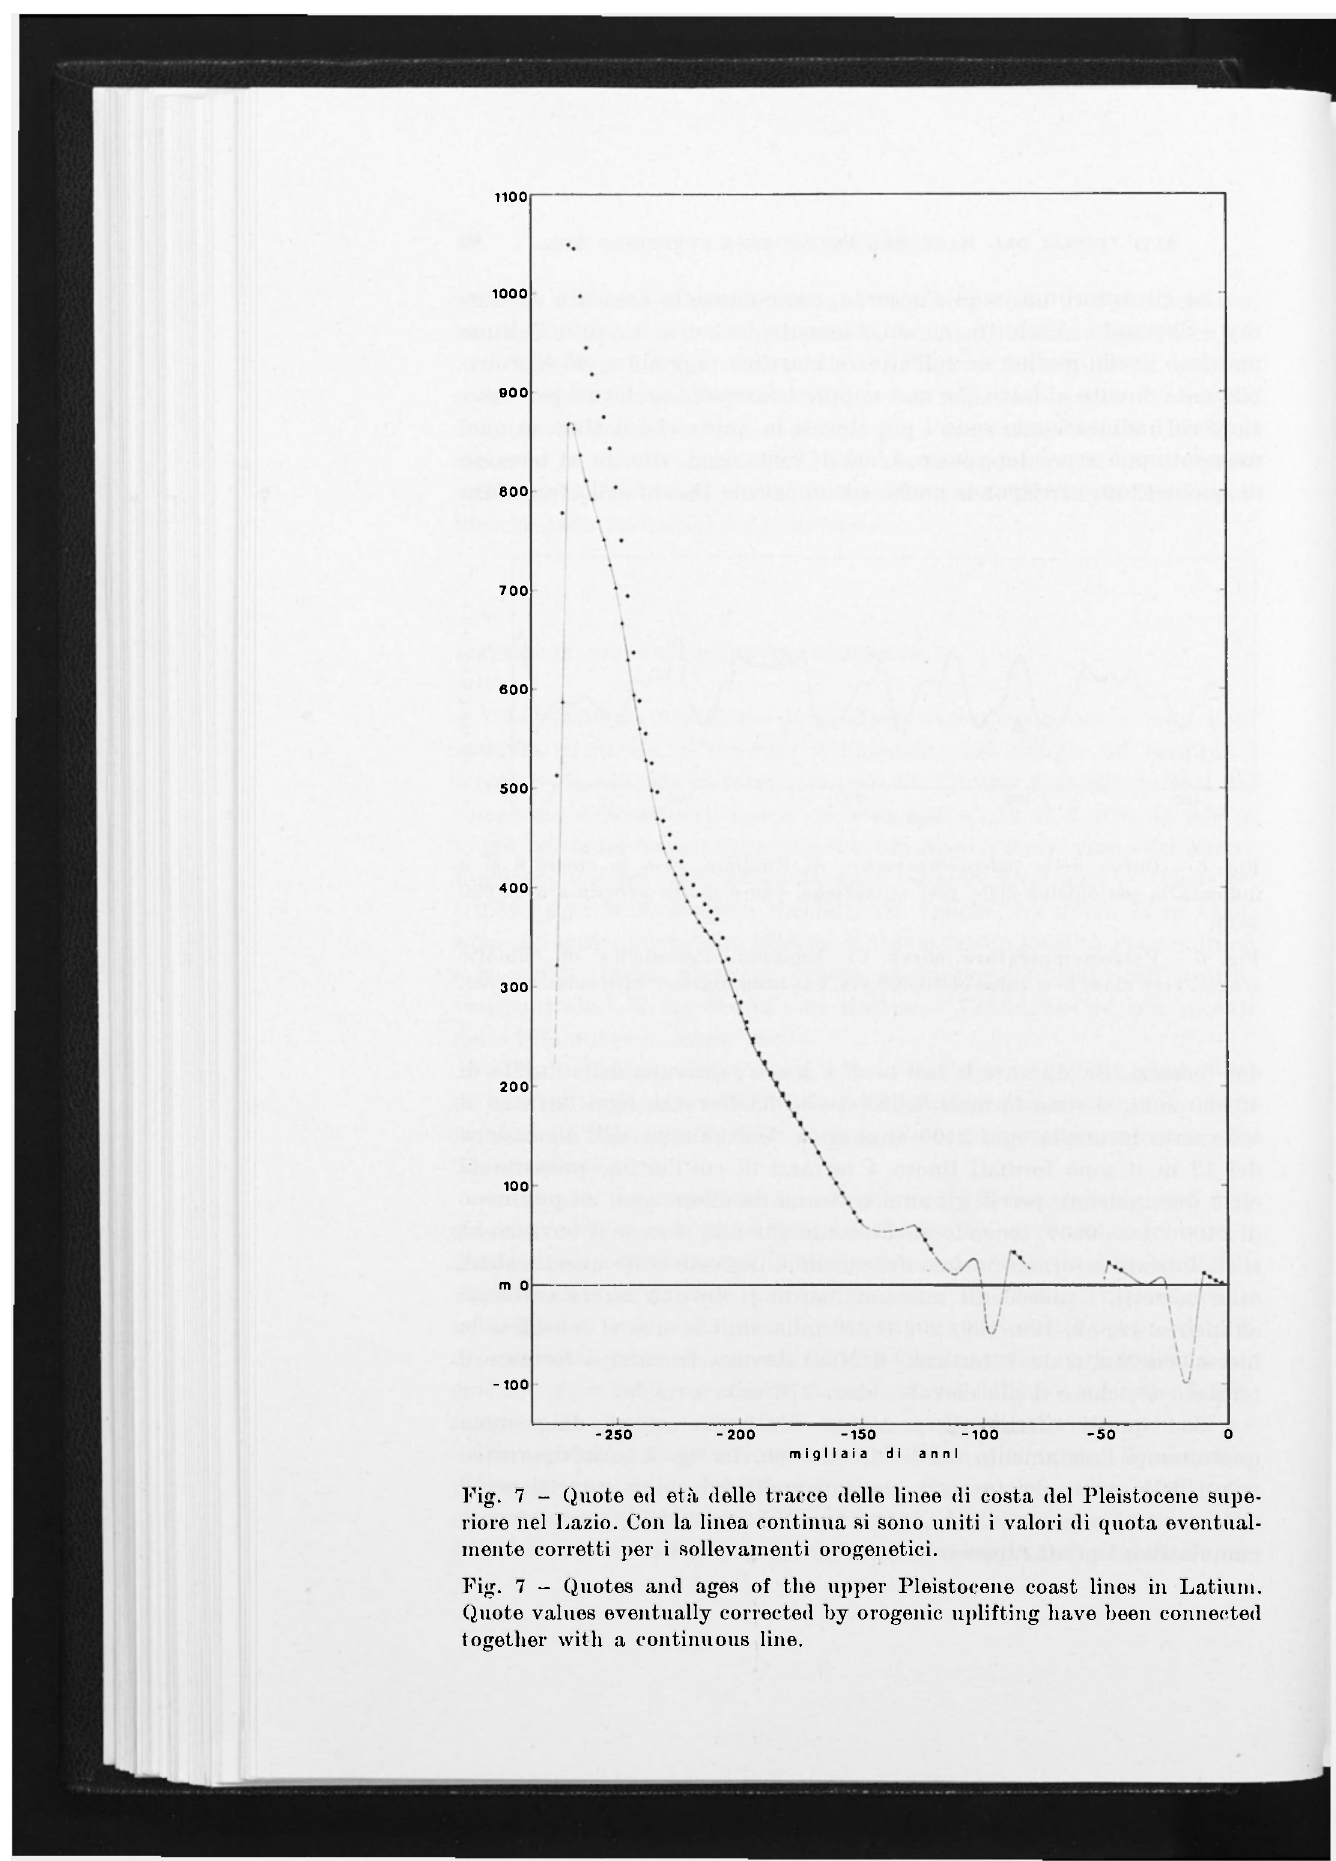
Fig. 7 - Quote ed età delle tracce delle linee di costa del Pleistocene supe- riore nel Lazio. Con la linea continua si sono uniti i valori di quota eventual- mente corretti per i sollevamenti orogenetici. Fig. 7 - Quotes and ages of the upper Pleistocene coast linos in Latium. Quote values eventually corrected by orogenic uplifting have been connected together with a continuous